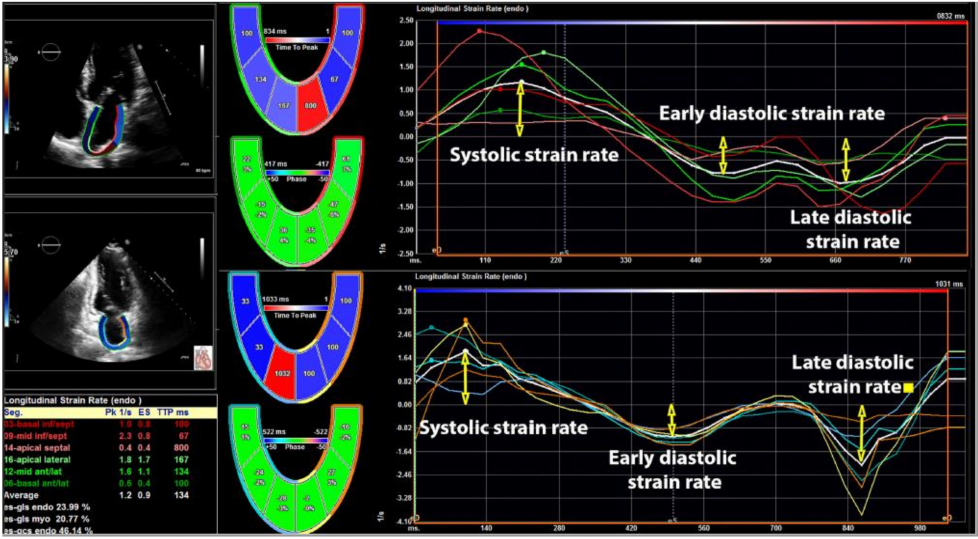
Figure 3. Assessment of left atrial longitudinal strain rates in four- and two-chamber